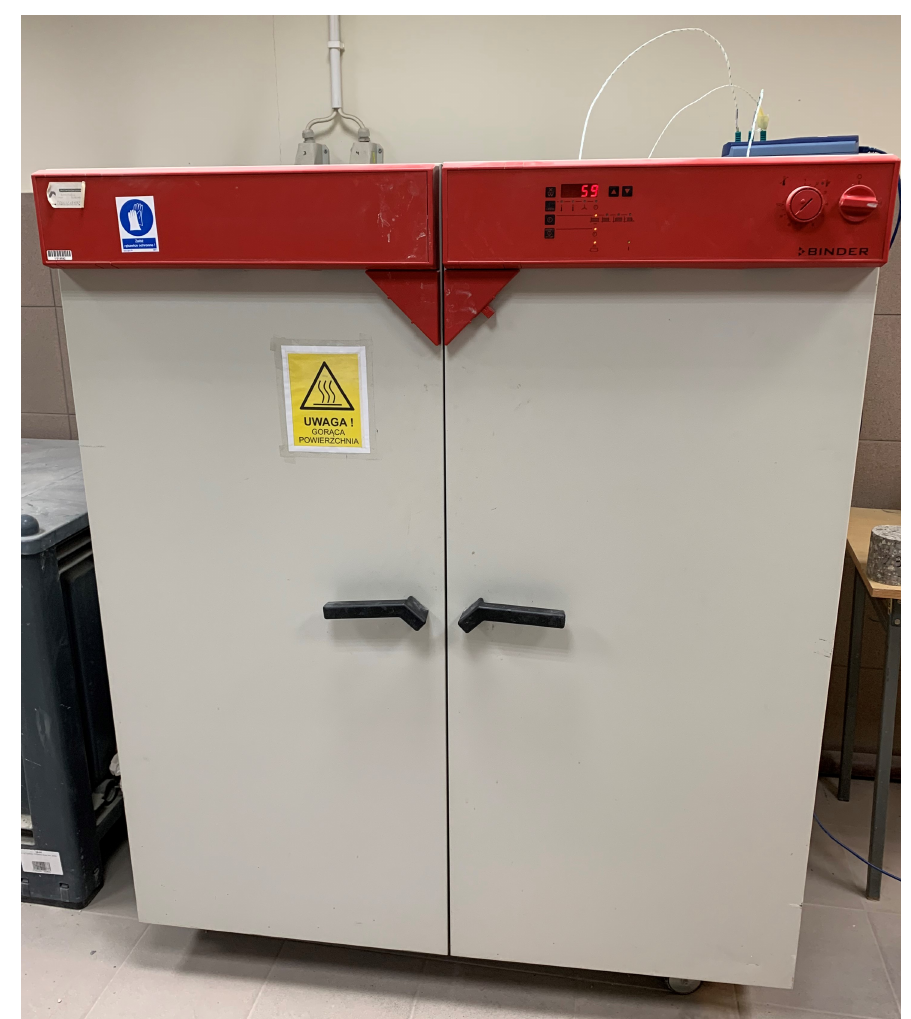
Figure 3. Climate chamber during the heating procedure of